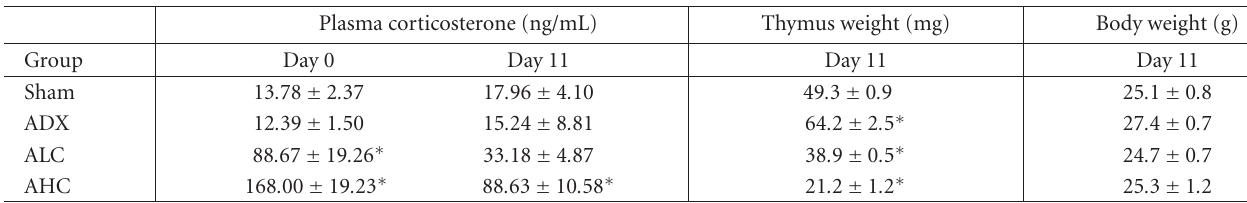
Table 3: Plasma corticosterone, thymus, and body weight. Corticosterone was measured before the first day of testing (day 0) and 24 hours after the last testing day (day 11). Data are presented as mean ±